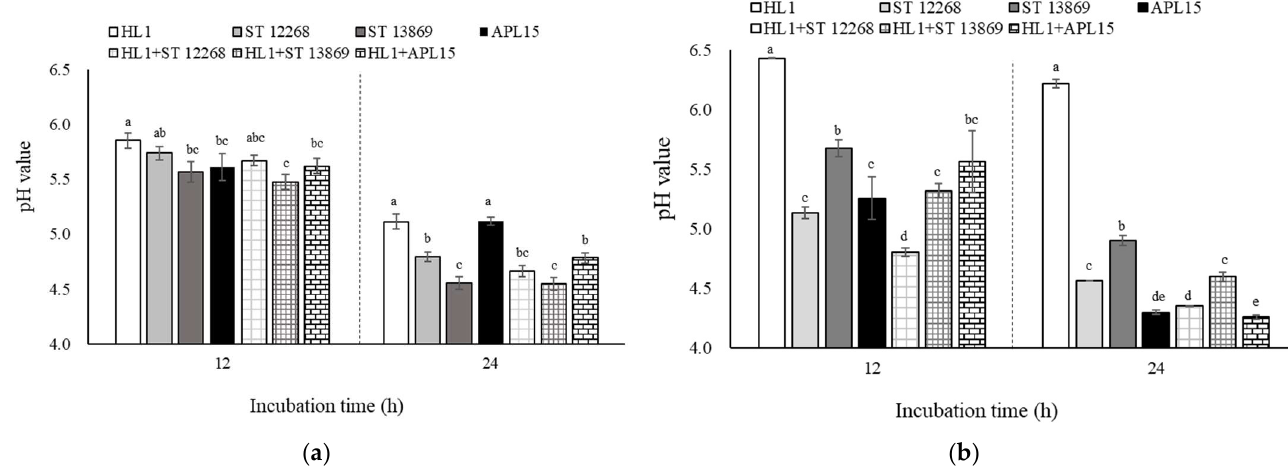
Figure 3. Effect of HL1 co-culturing with each selected strain on pH values of MRS broth ( a ) and skimmed milk ( b ) for both 12- and 24-h fermentation. Data are given as mean ± SD ( n = 3). a–e Mean values without the common letter within the same incubation time indicate a significant difference ( p < 0.05). Abbreviations: HL1, L. kefiranofaciens HL1; ST 12268, S. thermophilus BCRC 12268; ST 13869, S. thermophilus BCRC 13869 T ; APL15, Lc. lactis subsp. cremoris APL15.